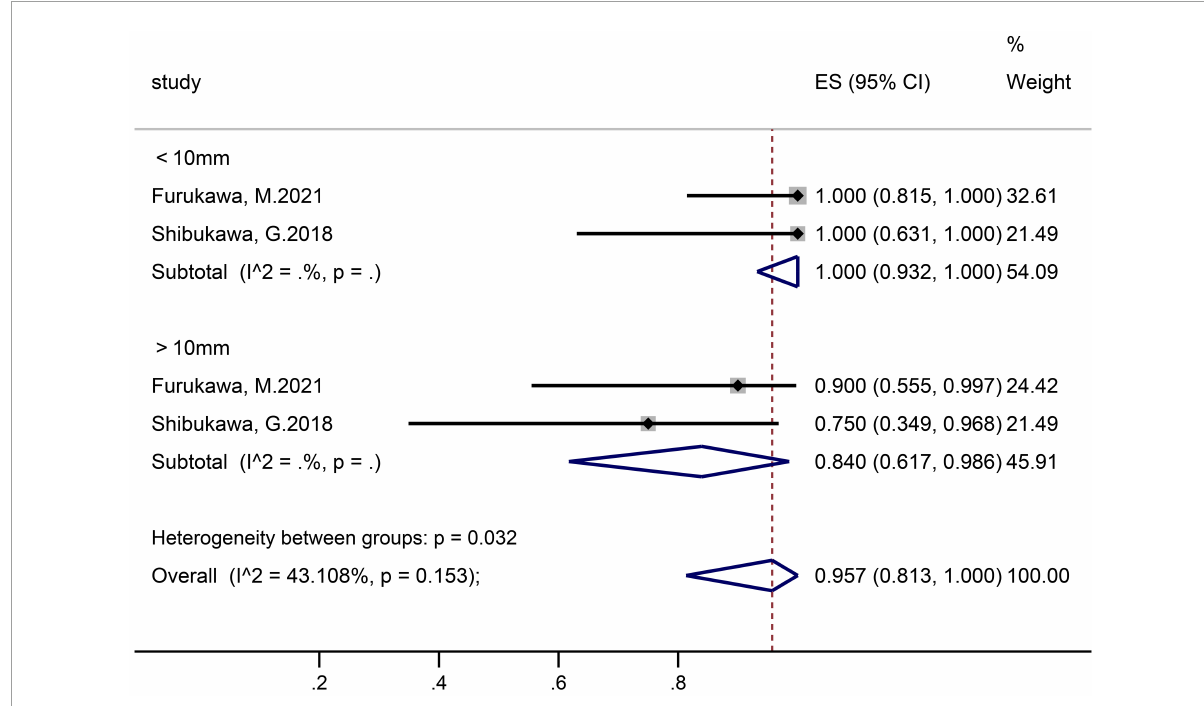
FIGURE4 Forest plot, en-bloc resection rate, subgroup analysis according to tumor size.